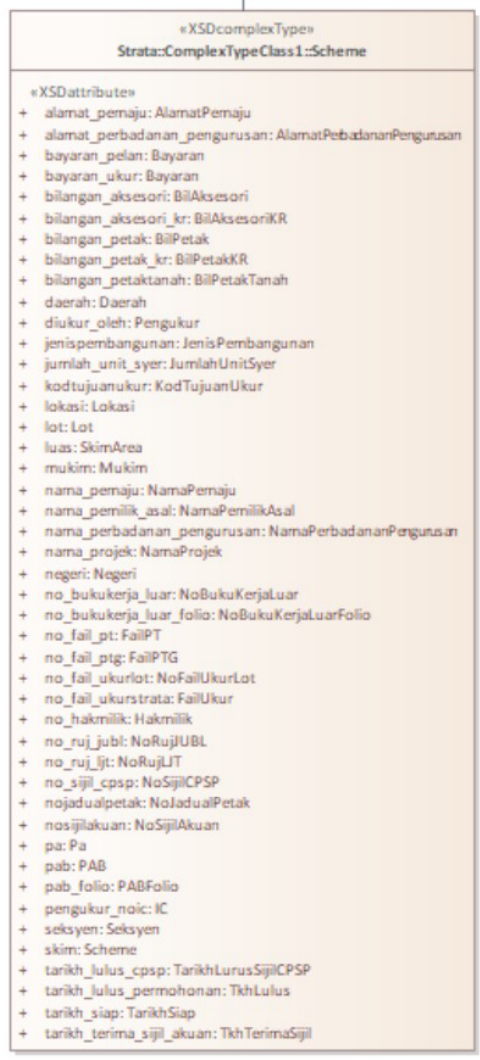
Figure 2 . The strata XML “Scheme”